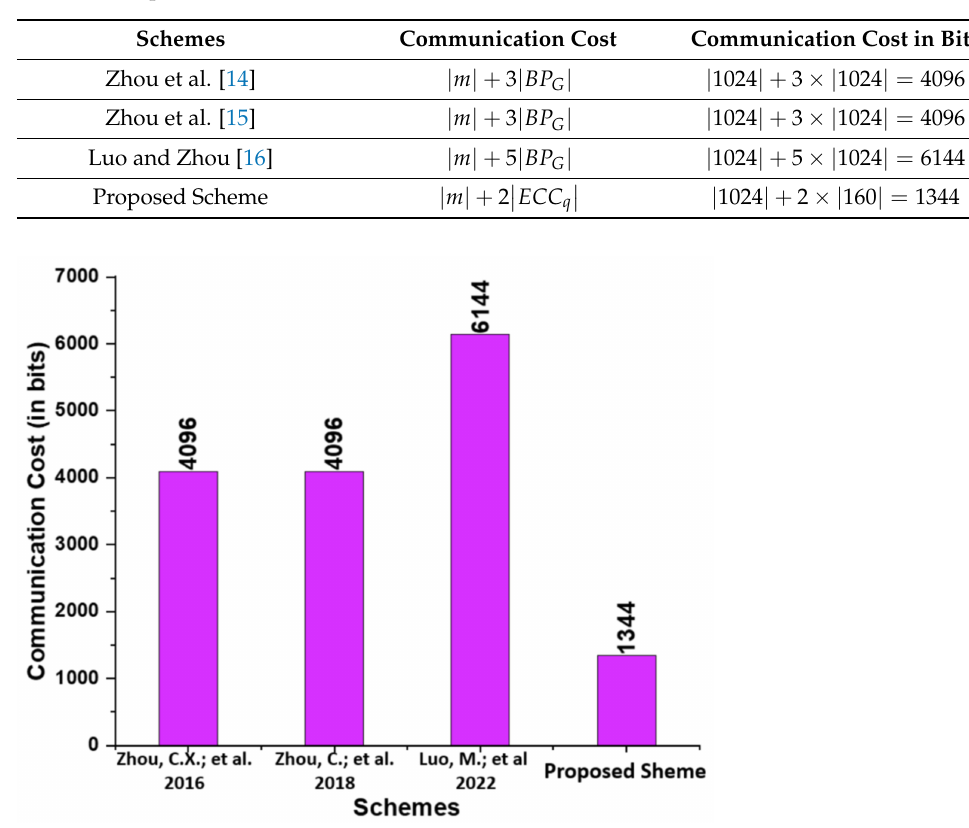
Table 4. Comparison of communication cost (in bits).